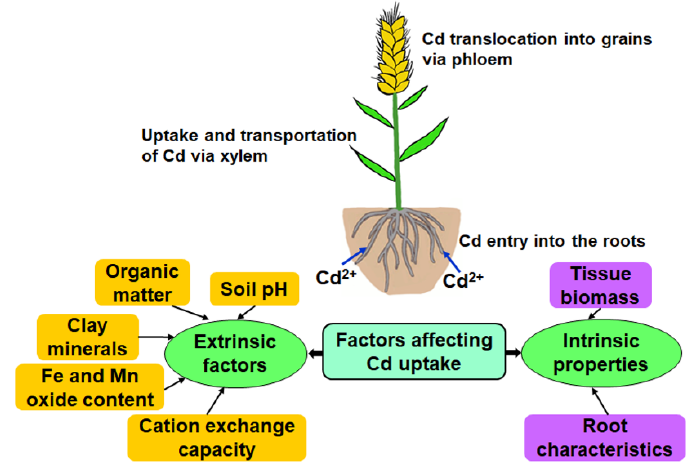
Figure 1. Factors affecting Cd uptake in wheat. Cd first enters the roots from the soil, then after uptake and transport via xylem, it eventually accumulates in the grain via phloem in wheat plants. It has been reported that Cd content in wheat grain was positively correlated with shoot biomass and root morphological parameters (such as volume, surface area and